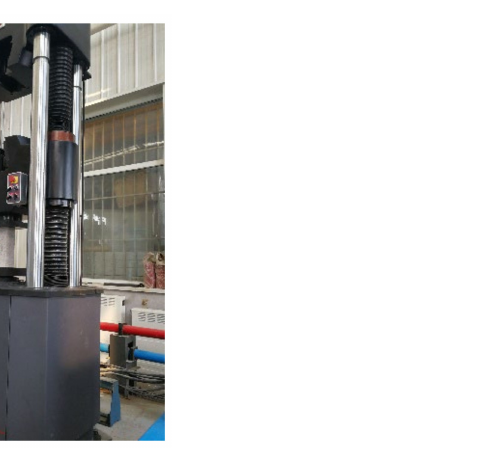
Figure 5. Loading equipment of electro-hydraulic servo universal testing